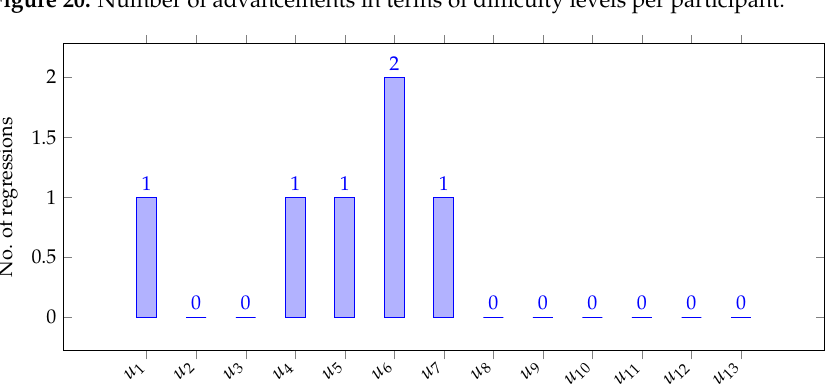
Figure 20. Number of advancements in terms of difficulty levels per participant.